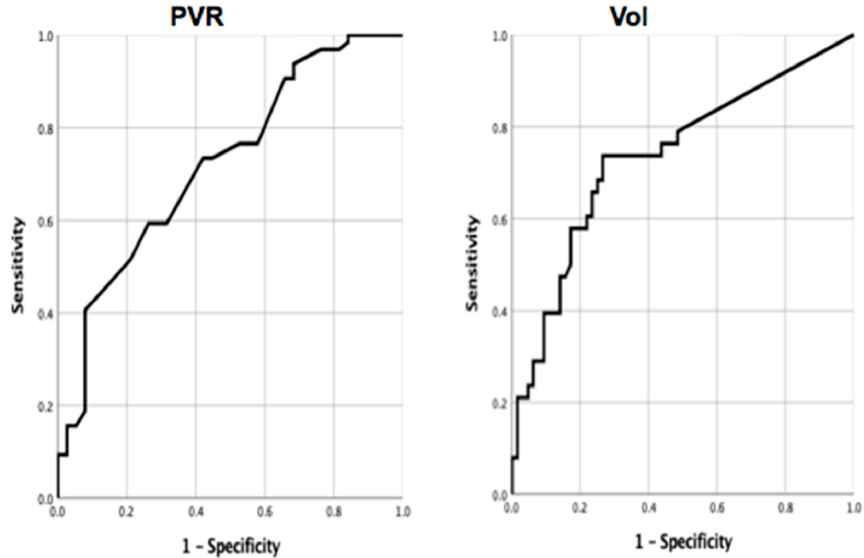
Figure 1. Receiver operating characteristic curves of baseline post-void residual urine (PVR) and voided volume (Vol.) for predicting satisfactory surgical outcome after transurethral incision of bladder neck. The area under the curve (AUC) values was 0.72 (95% confidence interval = 0.62 to 0.82) and 0.74 (95% confidence interval = 0.63 to 0.84), respectively. The optimal cutoff value of PVR was 335, with a specificity of 74.0% and a sensitivity of 59.0%, and of Vol. was 38 mL, with an acceptable specificity of 74.0% and sensitivity of 73.0%.